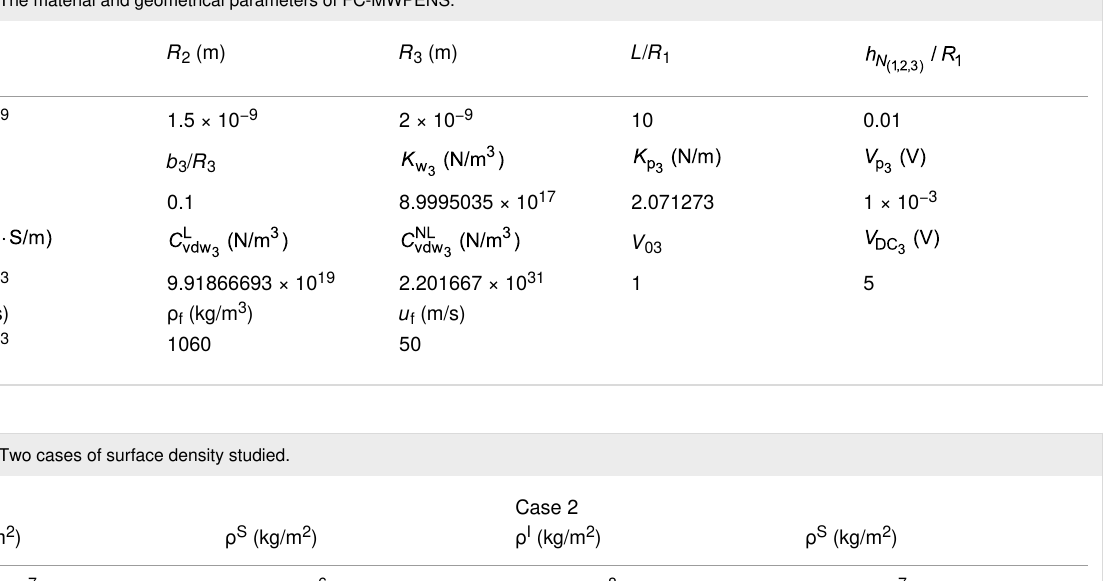
It is observed that for all modes, the DNF decreases when the L / R 1 ratio increases. Also, the DNF for mode 3 is higher